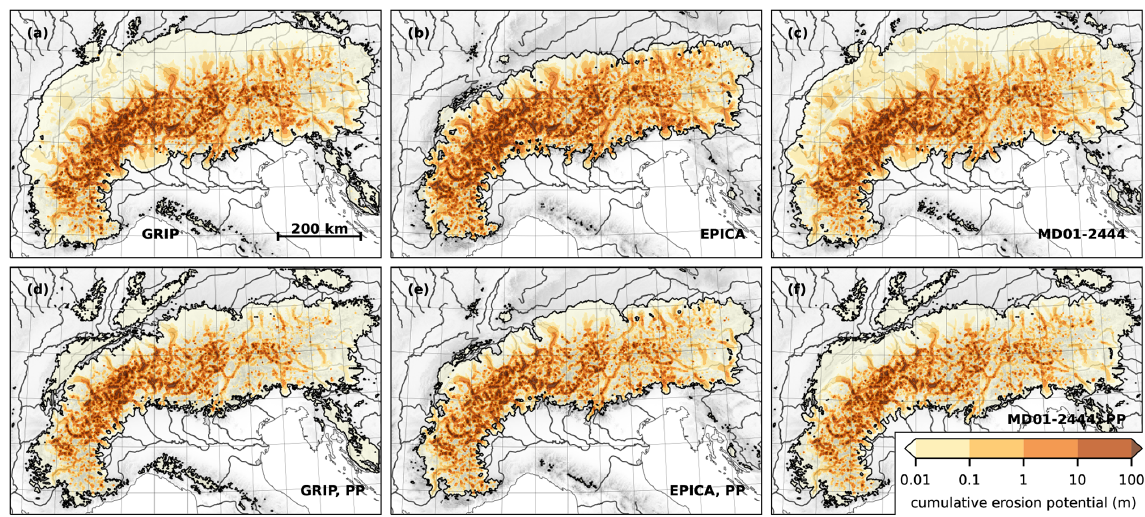
Figure 5. Modelled cumulative glacial erosion potential over the last glacial cycle using three different palaeo-temperature histories from (a, d) the Greenland Ice Core Project (GRIP; Dansgaard et al., 1993), (b, e) the European Project for Ice Coring in Antarctica (our default, EPICA; Jouzel et al., 2007), and (c, f) an oceanic sediment core from the Iberian margin (MD01-2444; Martrat et al., 2007), both (a–c) without and (d–f) with palaeo-precipitation reductions (Seguinot et al., 2018).